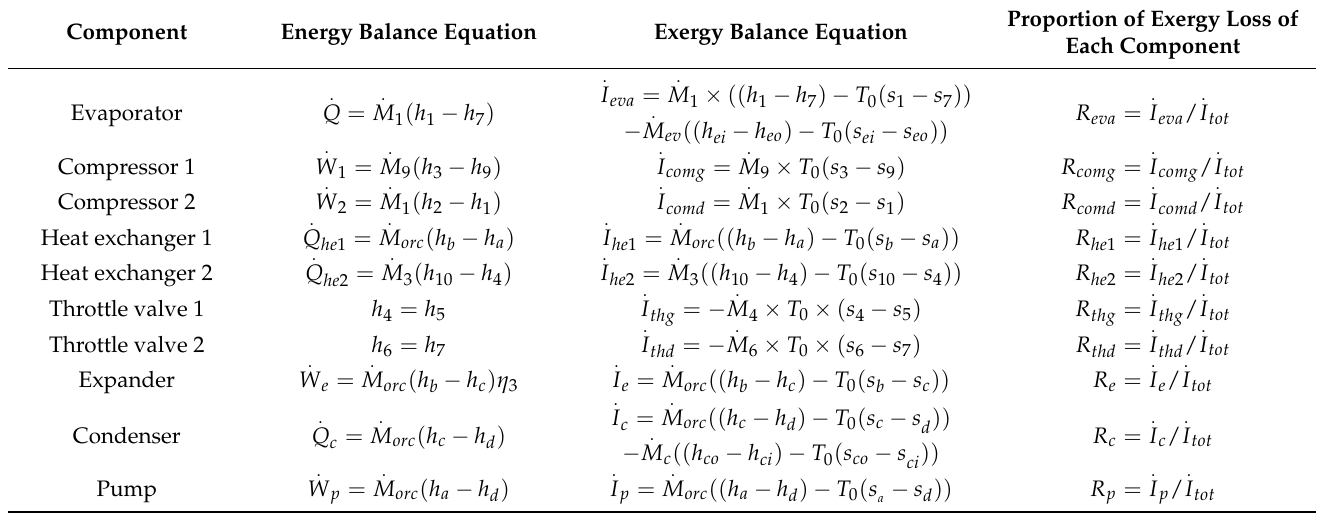
Table 1. Energy and exergy balance equations for the coupled system components [34].